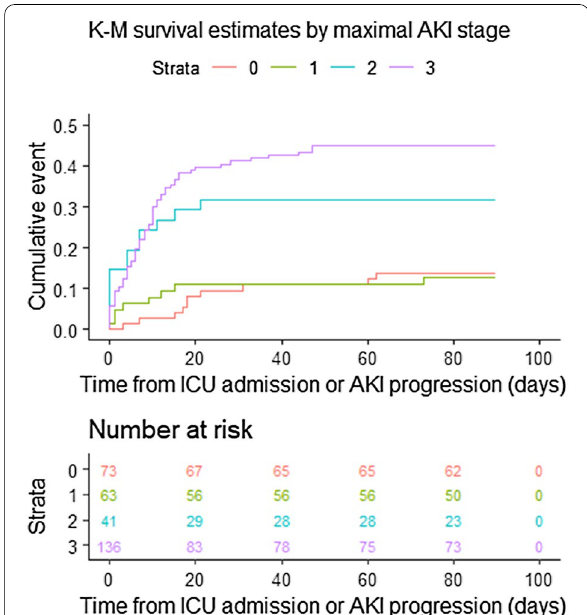
Fig. 1 Kaplan–Meier survival curves by maximal acute kidney injury (AKI) stage showing time from intensive care unit admission (in non-AKI patients) or from reaching maximal AKI stage (in AKI patients) to death or censoring at 90